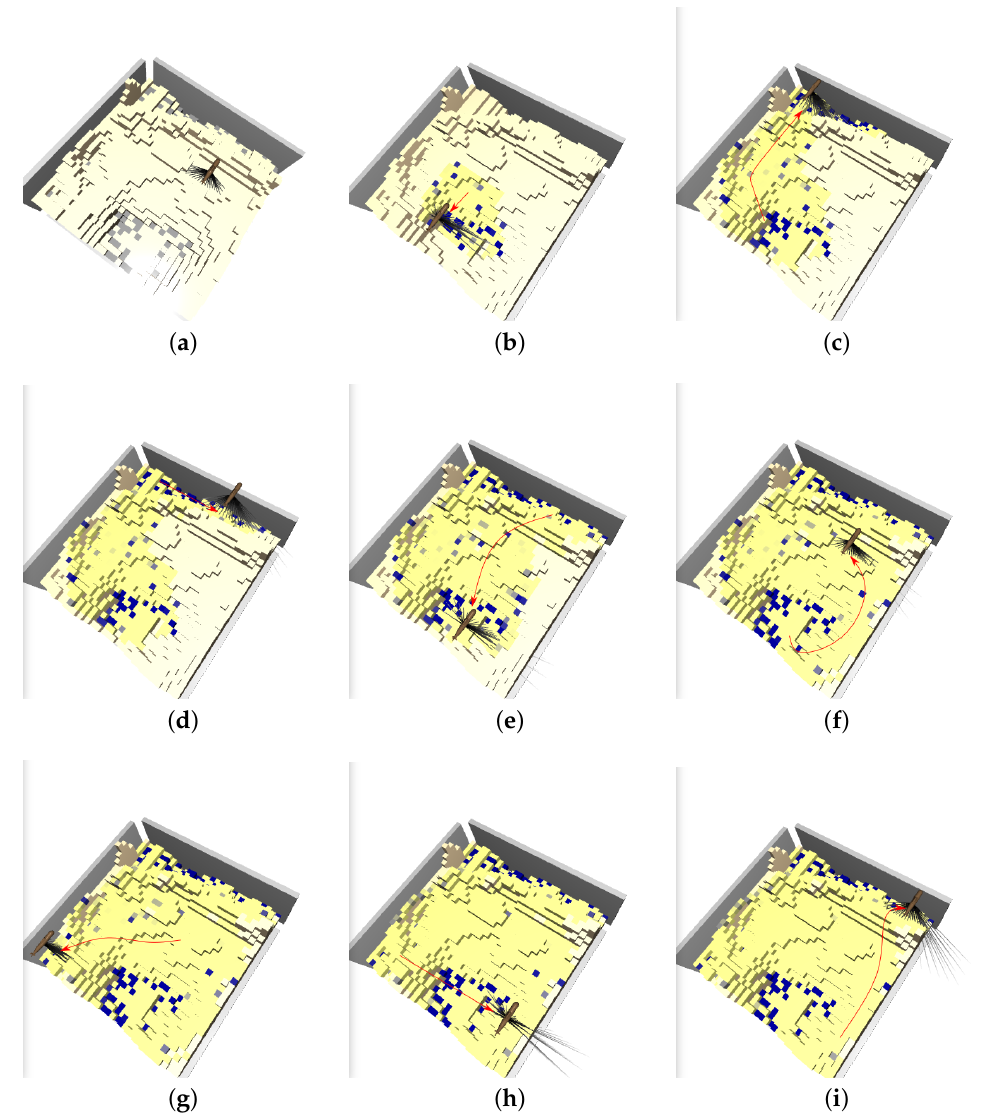
Figure 20. Visualization of the best agent’s trajectory using a sequence of snapshots ( b – i ). The first map ( a ) shows the ground truth (recall that litter is gray, low beliefs are yellow, and large beliefs are blue). The agents moves from the center directly to a valley where it finds large quantities of litter ( b ). Note that in ( c ), the agent does not take the shortest path to the next valley, likely because it is more efficient to approach the valley from one side instead of driving directly into the middle and then measuring parts of the valley